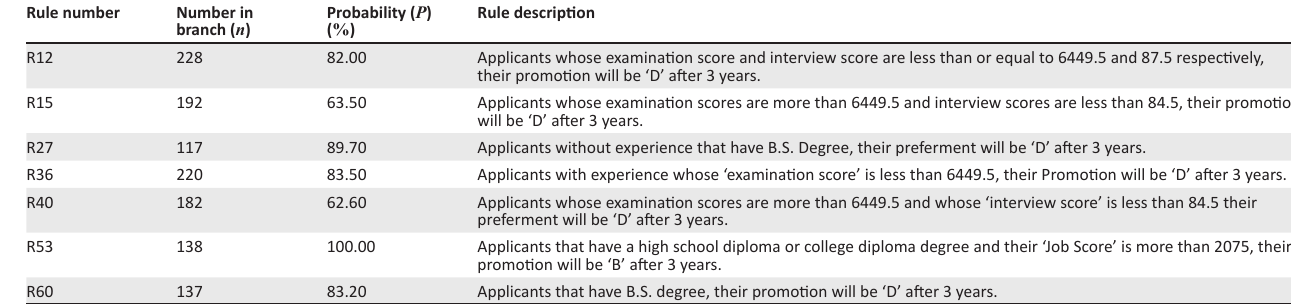
TABLE 7: The final rules sample. Rule